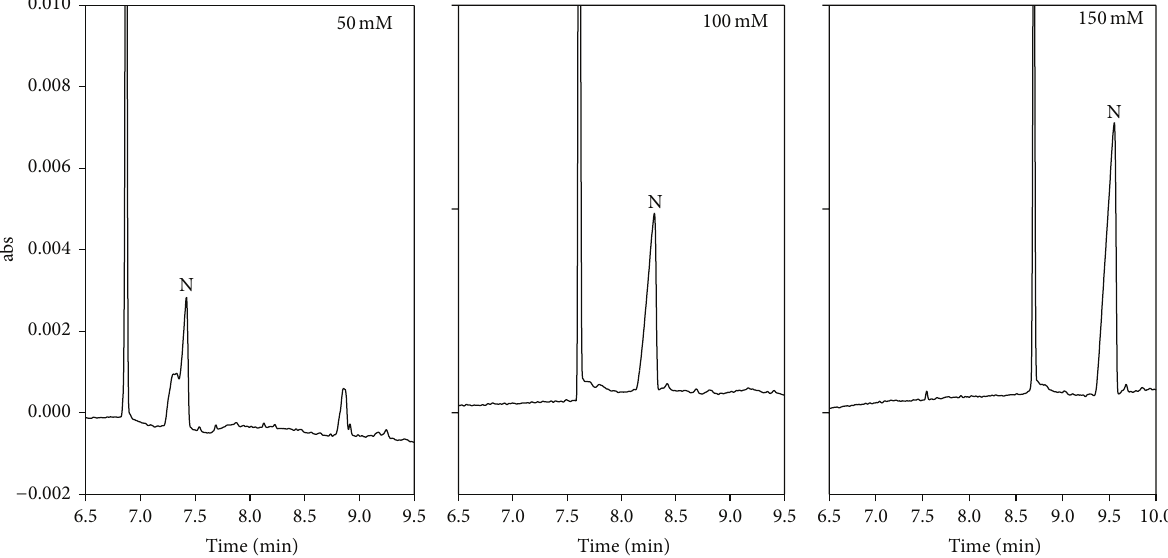
Figure 3: Effect of HCB concentration by CSEI-sweeping-MEKC. Separation buffer: 50 mM phosphate buffer (pH 3) containing 20% methanol; sweeping buffer: 50mM phosphate buffer (pH 3) containing 20% methanol and 50 mM SDS; HCB: phosphate buffer (pH 3); applied voltage, − 20 kV. Sample injection: 15 kV, 15min. Nicotine concentration: 617 nM.